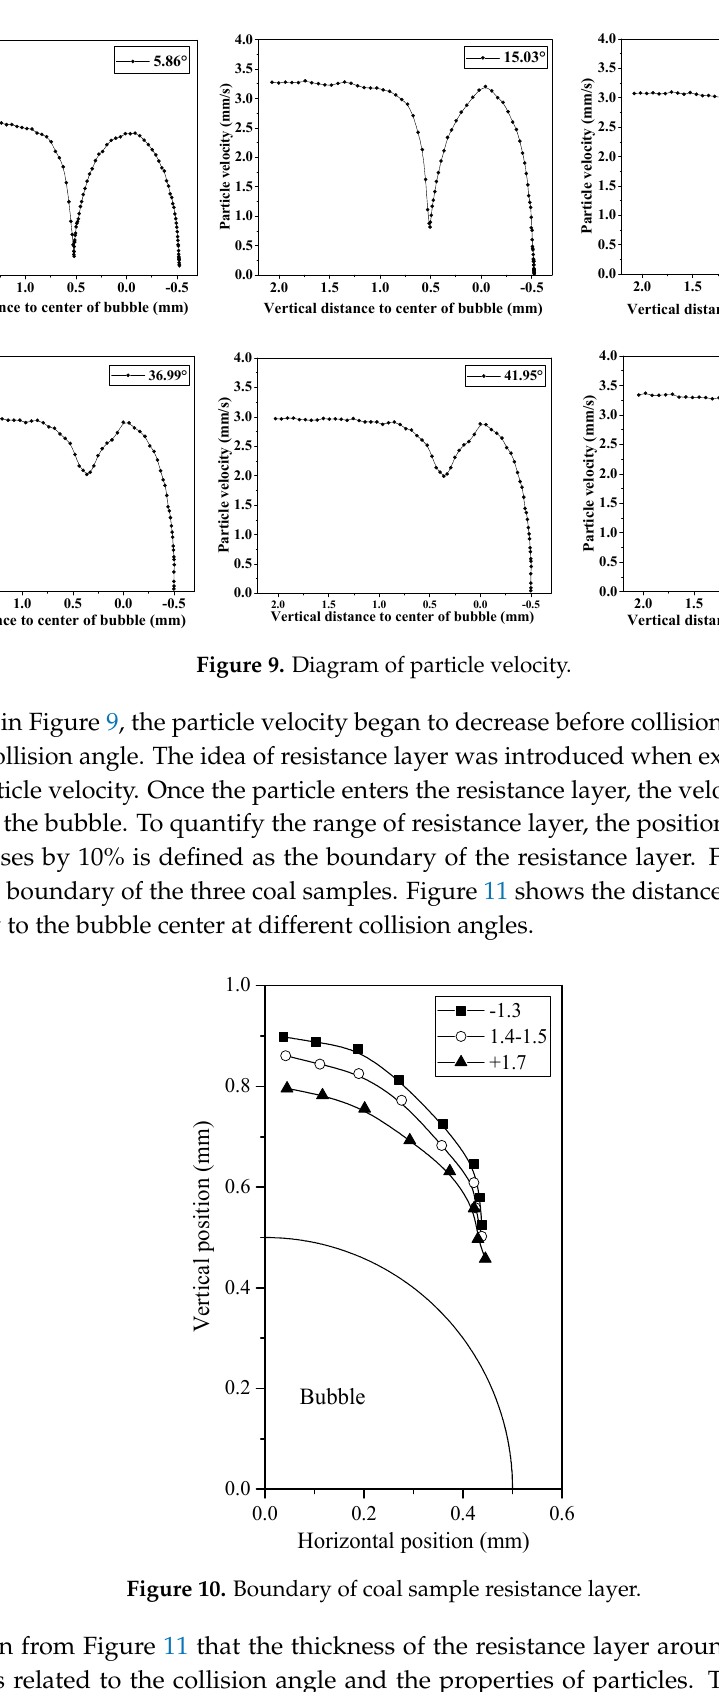
Figure 10. Boundary of coal sample resistance layer.